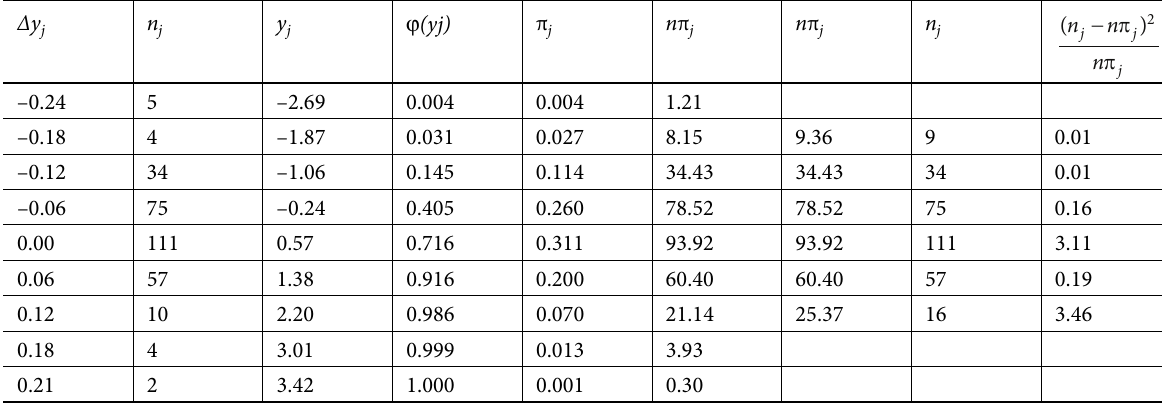
Table 5. Calculation schema of test statistic χ y 2 for the Y coordinate axis (Přívoz cad. district) Δy